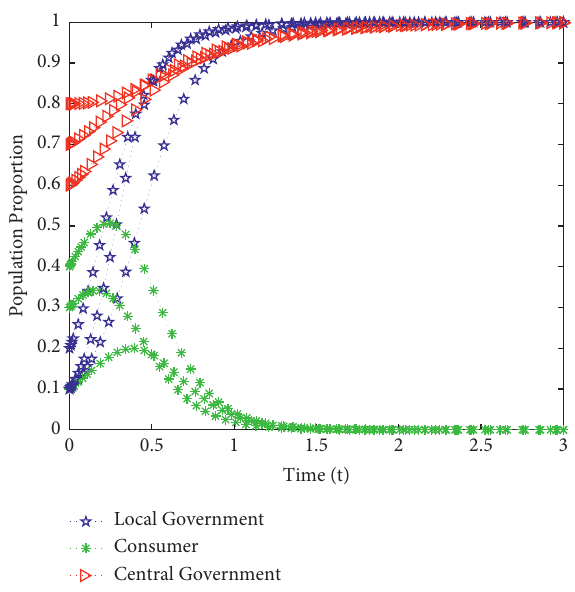
Figure 11: Evolution path of strategies chosen by three players with the stability point E 6